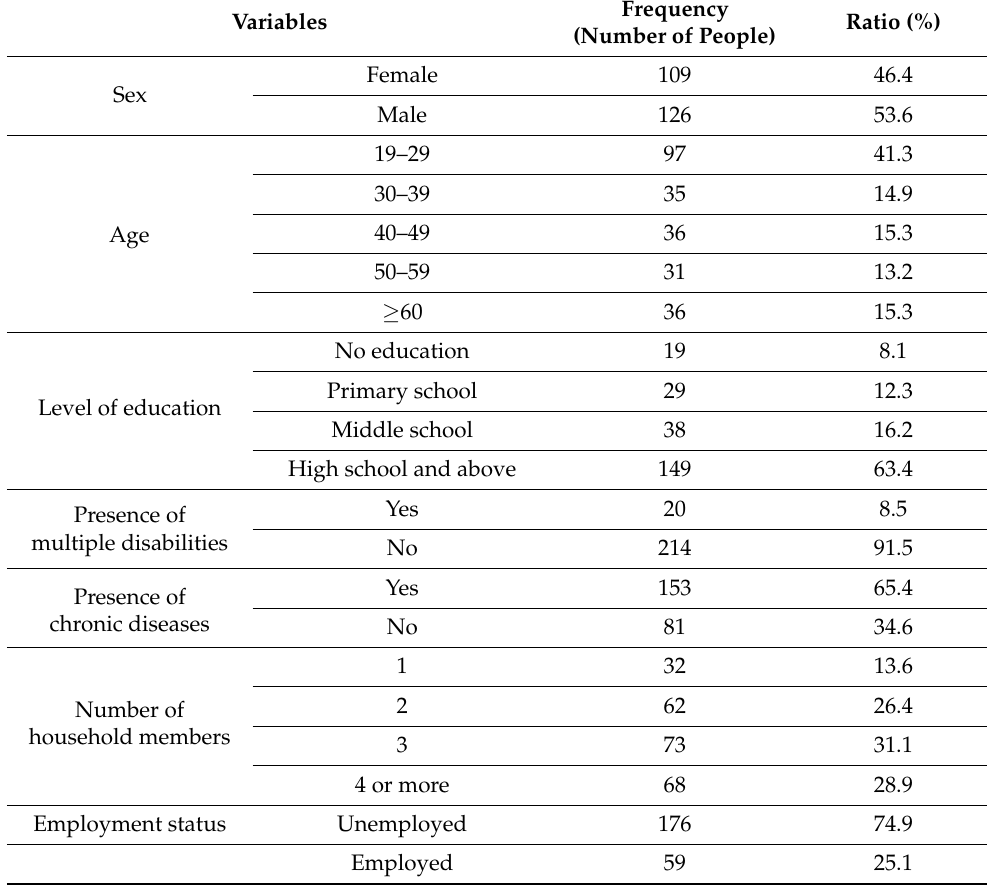
Table 1. General characteristics of the research